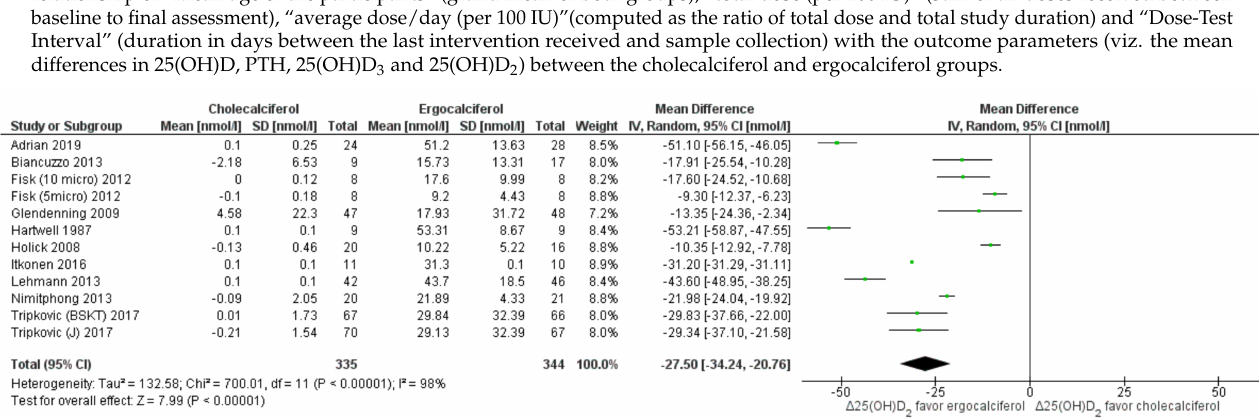
Figure 5. Forrest plot for 25(OH)D 2 . Legend: Forrest plot of random effect meta-analysis comparing the effects of cholecalciferol vs. ergocalciferol supplementation on net changes in 25(OH)D 2 concentrations favored ergocalciferol. “ ∆ 25(OH)D 2 ” denotes the change in 25(OH)D 2 concentrations from baseline (net change), squares denote the mean differences (with 95% confidence interval), i.e., the pooled results indicate mean difference of − 27.5 nmol/L (95% confidence interval: − 34.24 to − 20.76 nmol/L), favoring ergocalciferol supplementation. However, the studies are highly heterogeneous ( I 2 =